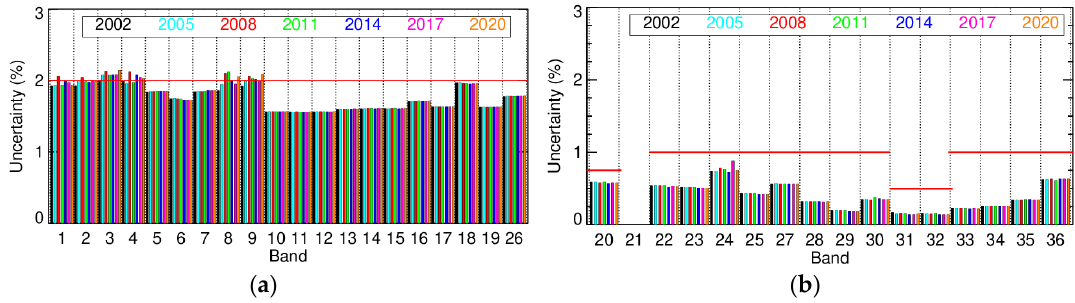
Figure 16. Aqua MODIS RSB ( a ) and TEB ( b ) calibration uncertainties in different years (marked with different colors) at typical radiance and nadir AOI (horizontal red line: Calibration requirement) .